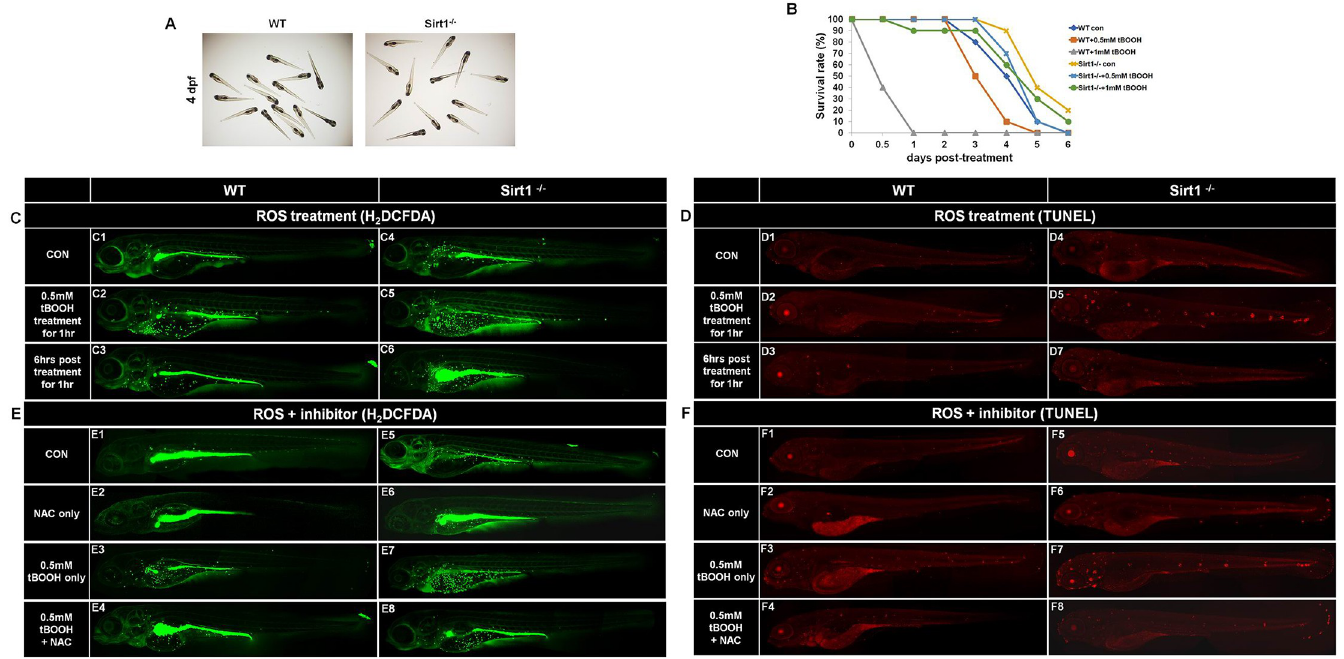
Fig 2. Short term phenotype of Sirt1 -/- mutants. Four-days post fertilization embryos were used to obtain representative images of short term phenotypes of wildtype and Sirt1 -/- mutants. (A) Phenotypes of wildtype and Sirt1 -/- zebrafish embryos. Note there are no differences in appearance between wildtype and Sirt1 -/- mutant embryos. (B) The embryo survival curves of wildtype and Sirt1 -/- mutants after treatment with 0.5 or 1 mM tBOOH. Note that wildtype embryos died earlier than Sirt1 -/- mutants. (C) ROS levels in 0.5 mM tBOOH-treated wildtype and Sirt1 -/- embryos were examined by H 2 DCFDA fluorescence. (D) Detection of apoptosis in 0.5 mM tBOOH-treated wildtype and Sirt1 -/- mutant embryos by TdT-mediated dUTP nick end labeling (TUNEL). Note that Sirt1 -/- mutants showed higher levels of ROS and TUNEL than wildtype embryos. The effect of NAC treatment on ROS content and apoptosis incidence was studied by H 2 DCFDA fluorescence (E) and the TUNEL assay (F). Embryos were exposed to treatment with NAC treatment for 24 h. Results showed that TUNEL-positive cells increased in both, tBOOH-treated wildtype and Sirt1 -/- groups; furthermore, NAC treatment was effective for both